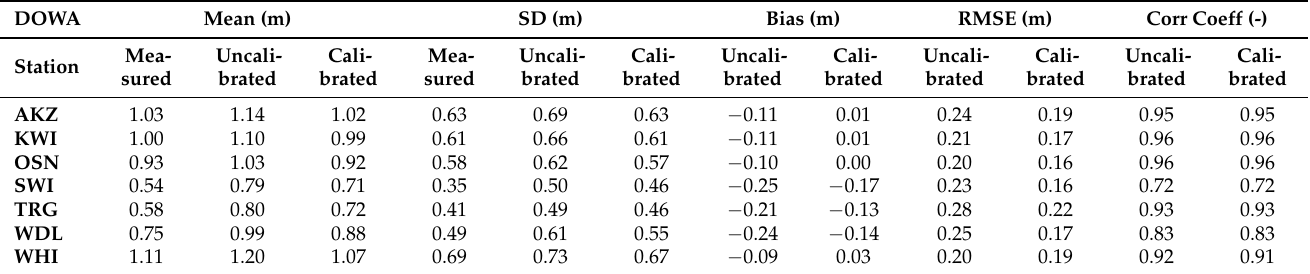
Table 8. Significant wave height statistical parameters calculated for the calibrated and uncalibrated SWAN models, 2.5 km × 2.5 km computational grid, forced by the DOWA database.